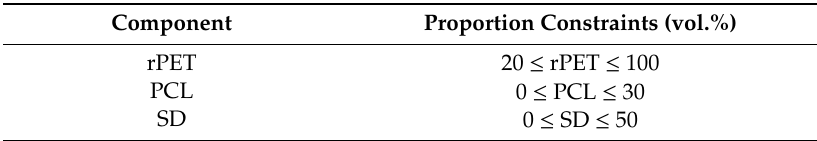
Table 2. Composition design sapce for the rPET WPC statistical mixture experiment.